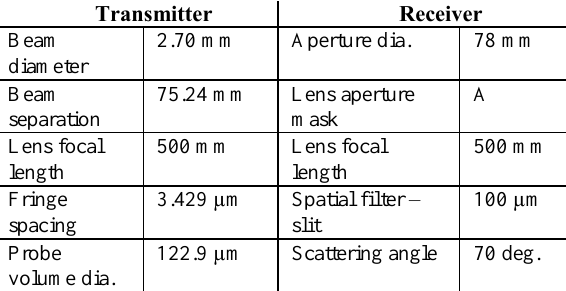
Table 1. Optical set up